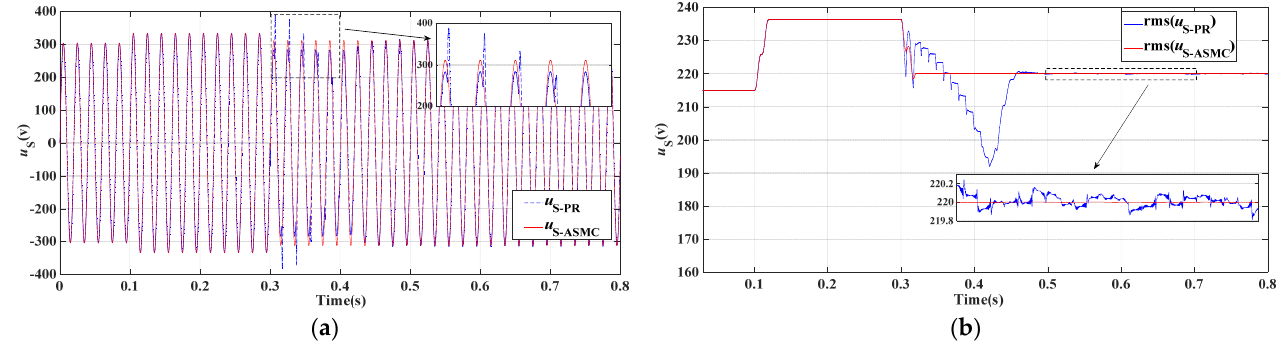
u under ASMC and PR control when ES works in resistive mode: ( a ) Figure 5. Comparison of Figure 5. Comparison of u S under ASMC and PR control when ES works in resistive mode: S waveform comparison, ( b ) RMS comparison. ( a ) waveform comparison, ( b ) RMS comparison.